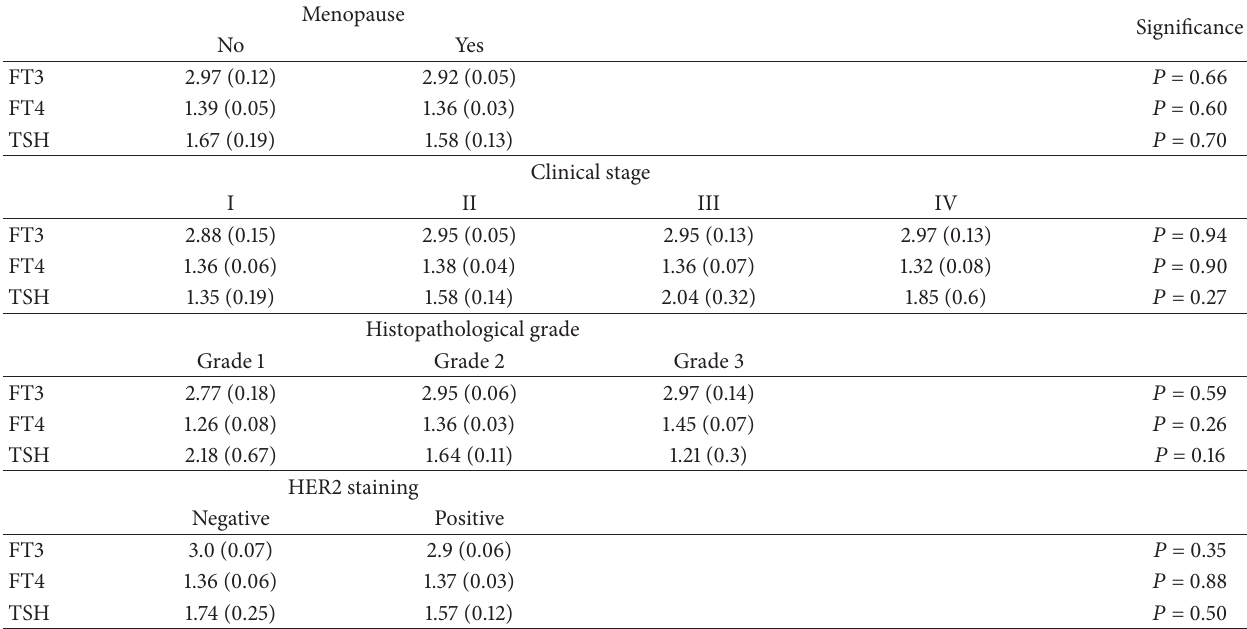
Table 1: Comparison of thyroid hormone levels in breast cancer patients based on menopausal status, clinical stage, histopathological grade, and HER2 staining.